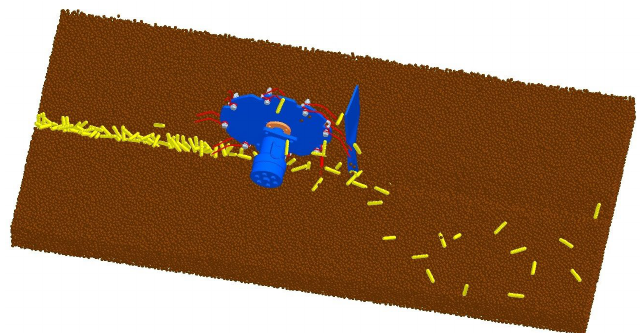
Figure 13. The seed furrow clearing process.